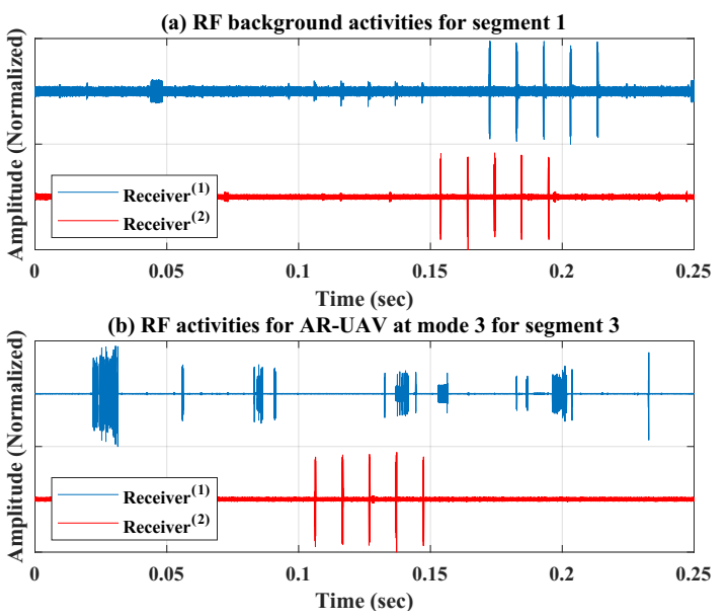
Figure 8. RF activities with normalized amplitudes ( − 1 and 1). ( a ) normal RF activities for segment 1. ( b ) RF activities for AR-UAV at mode 3 for segment